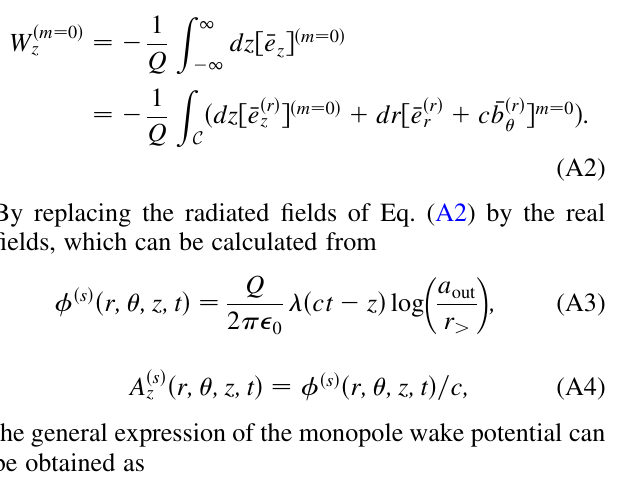
FIG. 5. (Color) The cavity and the integration path. The beam tube of the downstream side is denoted as a A closed loop G in the left figure consists of a straight line L at z (cid:1) (cid:2)1 . The contour C has radial offsets r the integration path is opposite to C . The contour (cid:1) C in the right figure which is composed of three longitudinal line segments at different radii connected by two radial segments is called ‘‘Napoly-Zotter contour’’ [3].